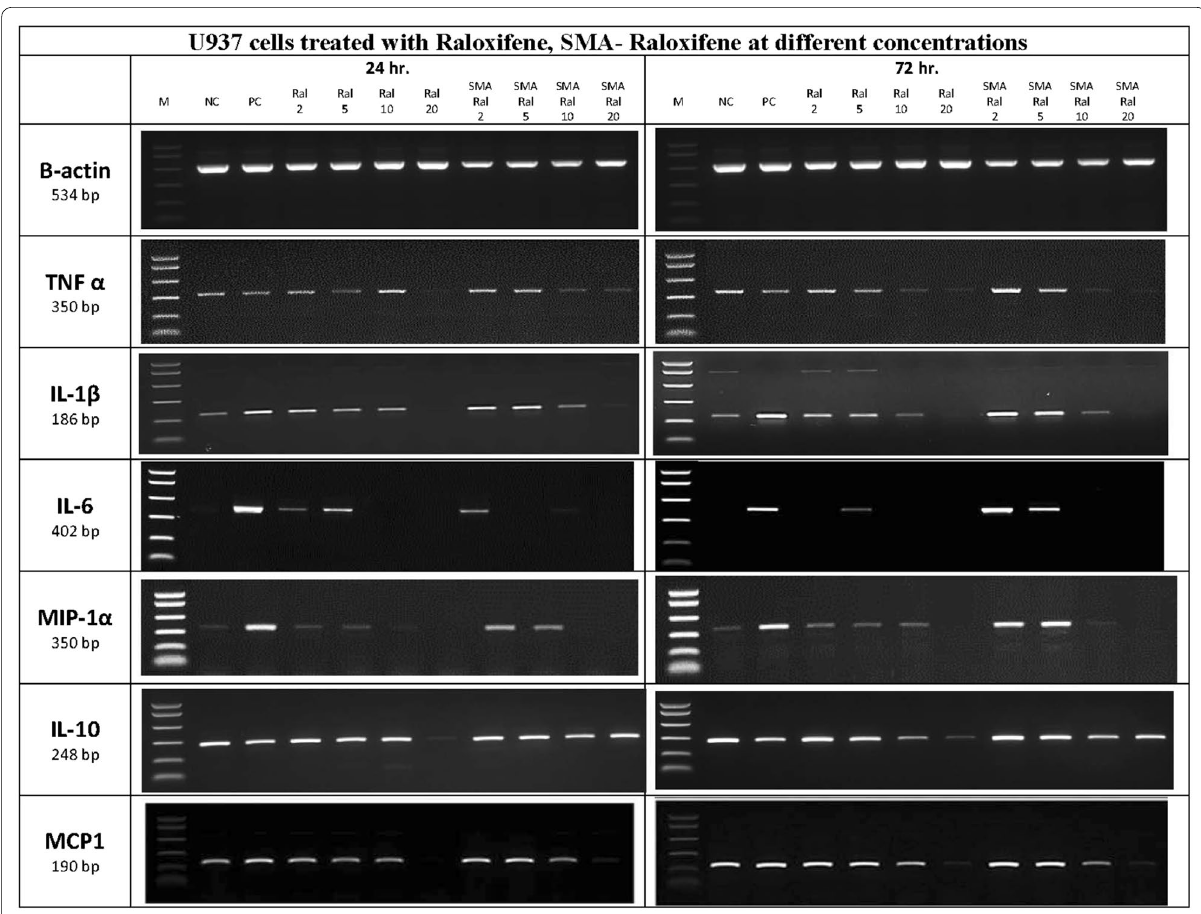
Fig. 1 cDNA samples (10 µl) of different inflammatory cytokines expressed by U937 cells, treated with different concentration of free or SMA Ral and visualized on 1.5% agarose